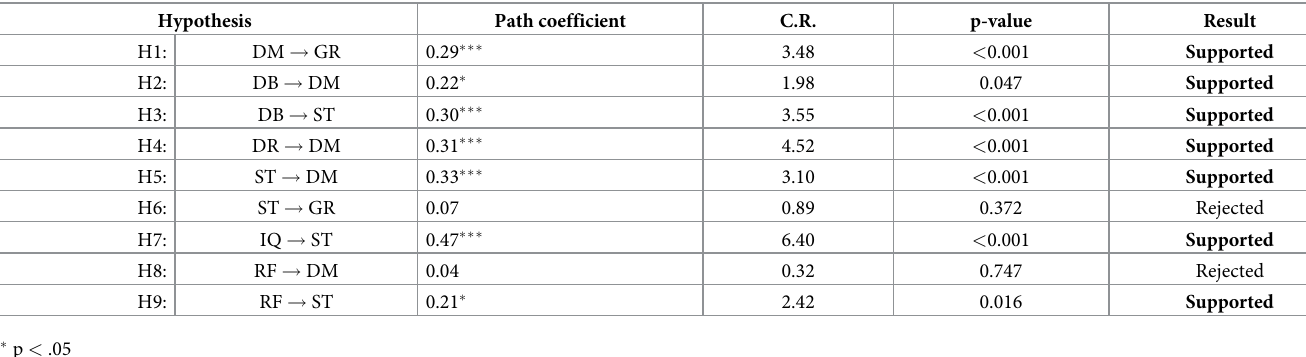
Table 6. Hypothesis test and